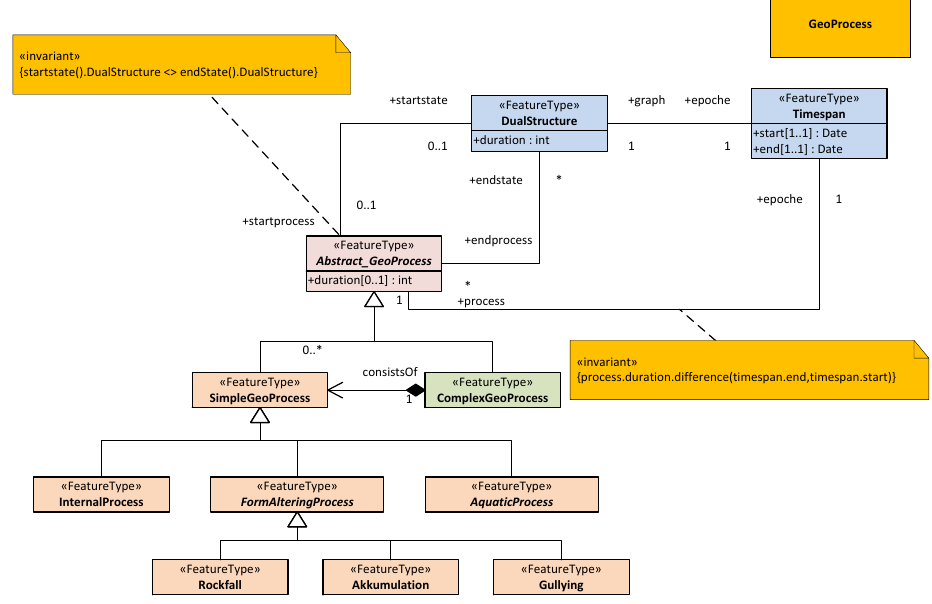
Figure 7. Abstract_GeoProcess as connection between